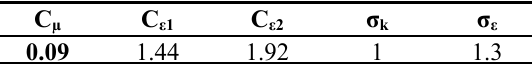
Table 1. Constant values of k –ε model